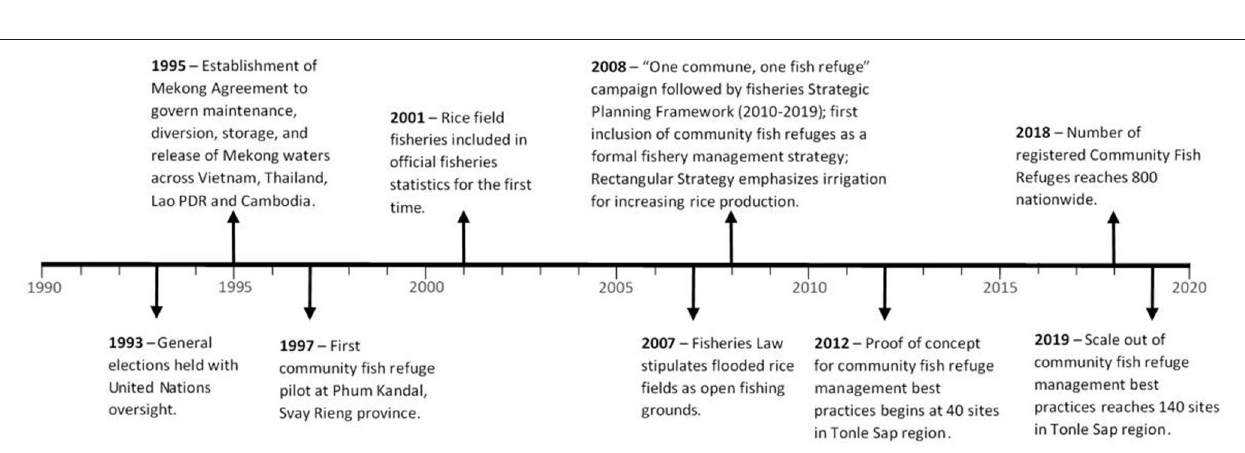
FIGURE 2 | Transformation pathways for rice-fish production practices. Starting from similar initial practices (predominantly rice field fisheries), rice-fish production in the four case study countries transitioned or transformed along different pathways according to their context and the objectives that followed from the Green Revolution (ca. 1985) onwards. During the present opportunity for food systems transformations, four potential pathways are foreseen, once again depending on the context and objectives in the push for sustainable food systems.